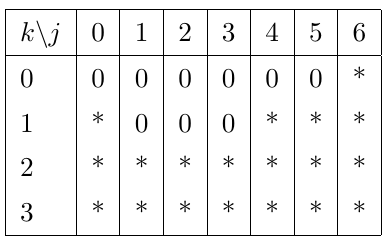
Table 25. Coe(cid:14)cients e b jk in equation (F.1). The coe(cid:14)cients which are identically zero are indicated by a ‘0’, while the rest are indicated by an